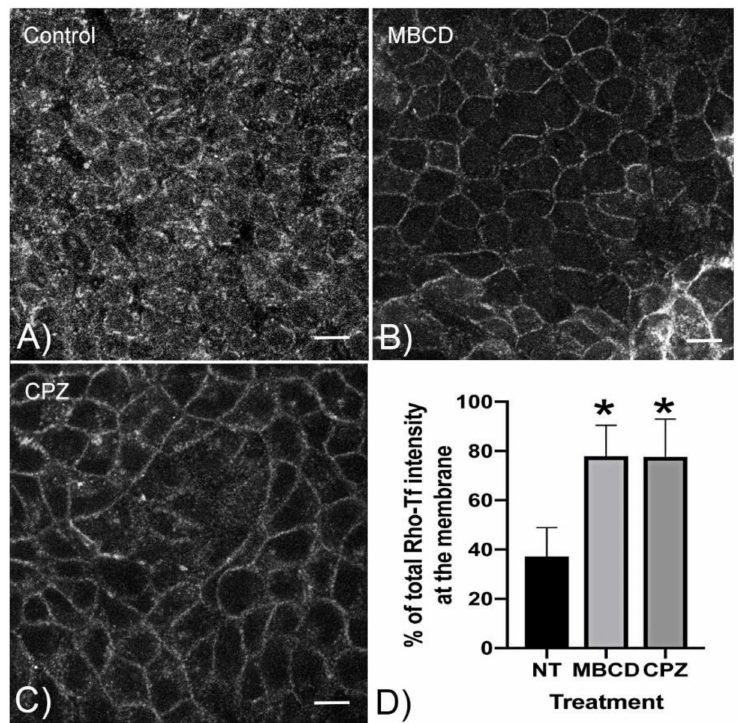
Figure 3. CPZ blocks endocytosis in AQP2-MDCK cells: Polarized AQP2-MDCK cells were grown on filters for 4 days ( A to C ). Cells were preincubated with methyl- β -cyclodextrin (MBCD) (10 mM), a nonspecific endocytosis inhibitor, or CPZ (100 µ M) for 15 min before the addition of Rhodamine-transferrin (Rho-Tf) (25 µ g / mL) to the basolateral side of the cells. After incubation